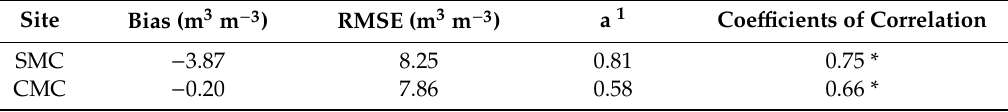
Figure 3. Comparisons between observed and estimated soil moisture at ( a ) SMC and ( b ) CMC site. Table 3. Statistical comparison between estimated and in situ measurements of